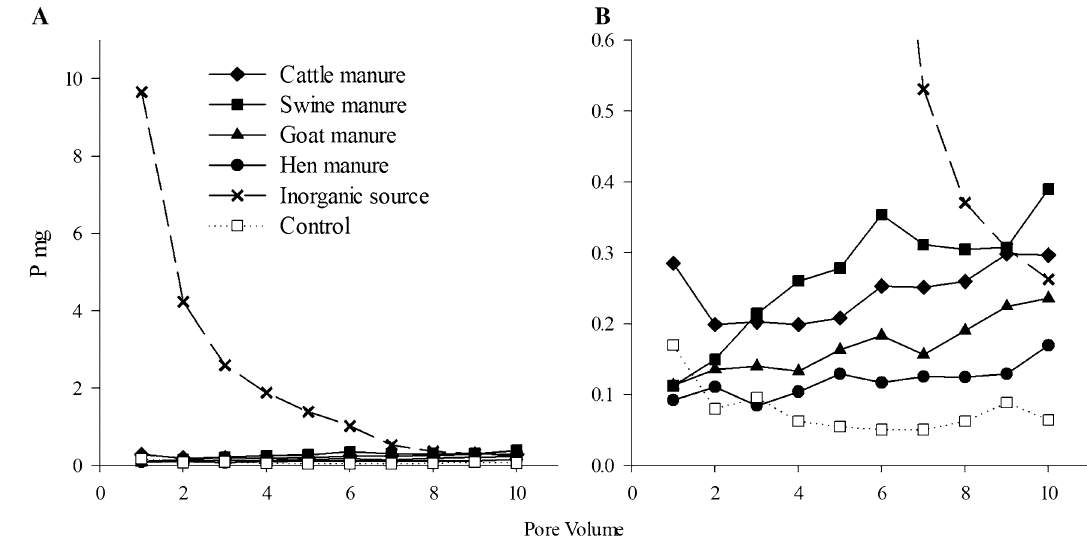
Fig. 1 Leaching of P (mg) for different sources in Dystric Xeropsamments in 20-cm columns as function of pore volume. a Leaching of P (mg) in all treatments; b the same a with cut in the “ y ”-axis at 0.6 mg of